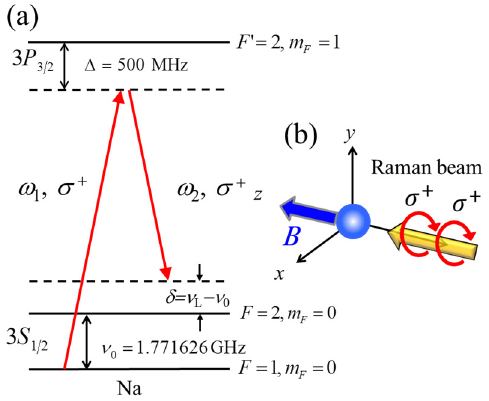
Figure 2. ( a ) A partial sodium energy-level scheme and two-photon Raman transition; ( b ) Experimental set-up. B : quantized magnetic field.